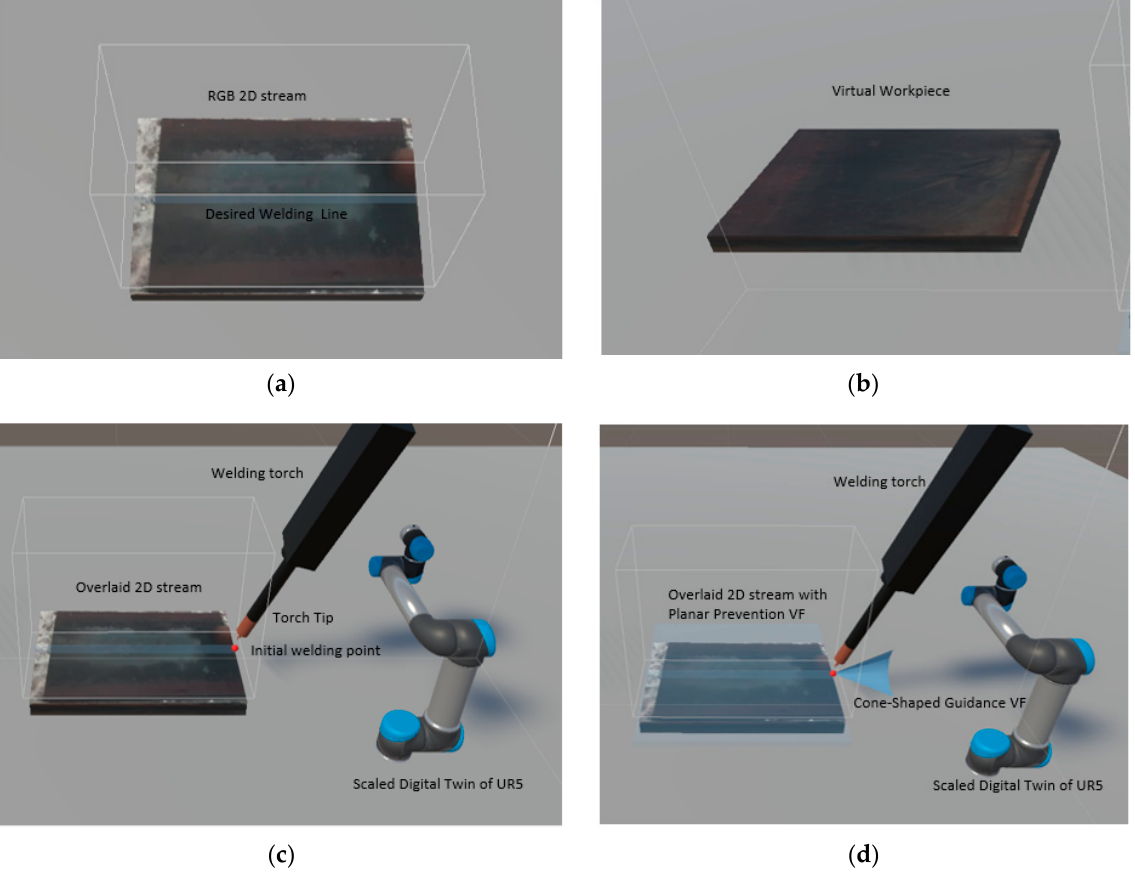
Figure 4. The visualization of tele-welding interaction modules used in the tele-welding experiments. ( a ) Typical 2D visual feedback for remote-controlled robotic welding where the user uses a monitor to observe the welding process, without the immersive HMD usage; ( b ) the virtual replica of the physical welding workpiece; ( c ) tele-welding MR platform without haptic effects including welding virtual workpiece, overlaid RGB stream, virtual welding torch, and the scaled digital twin of UR5; ( d ) the MRVF module involving hybrid guidance and prevention VFs.